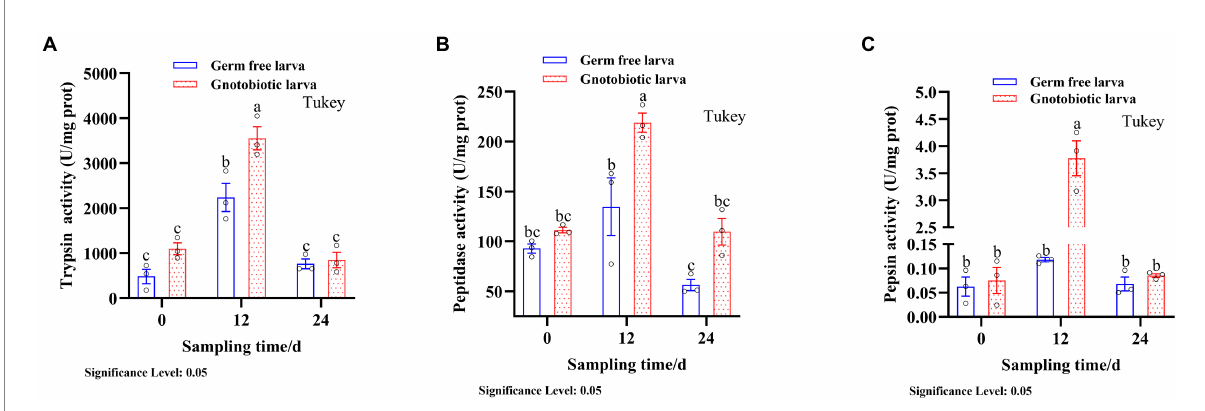
FIGURE 2 Protein digestive enzyme activities of gut samples, (A) trypsin activity; (B) peptidase activity; (C) pepsin activity. The group with the largest mean is annotated with the letter a. If there are statistically significant differences between groups, different letters shall be marked; otherwise, the same letters shall be